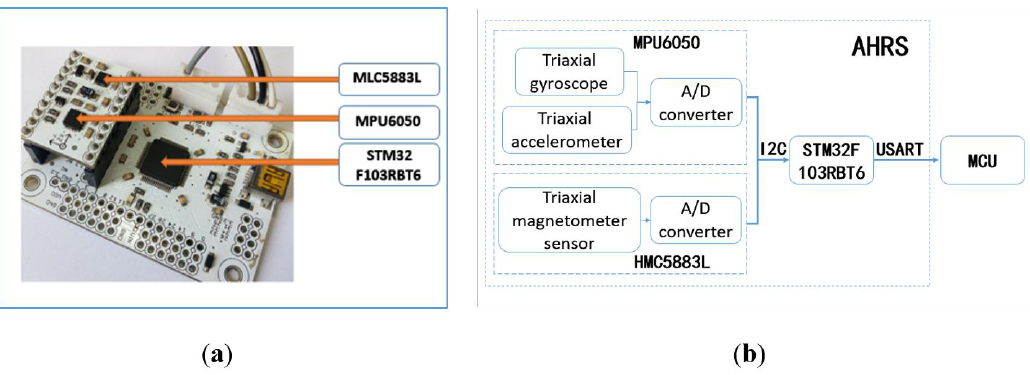
Figure 3. The hardware structure of each AHRS. ( a ) Hardware; ( b ) Configuration.